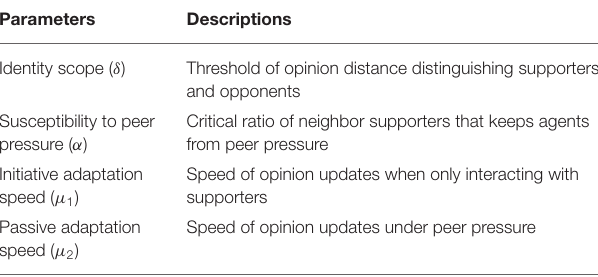
TABLE 1 | Descriptions of model